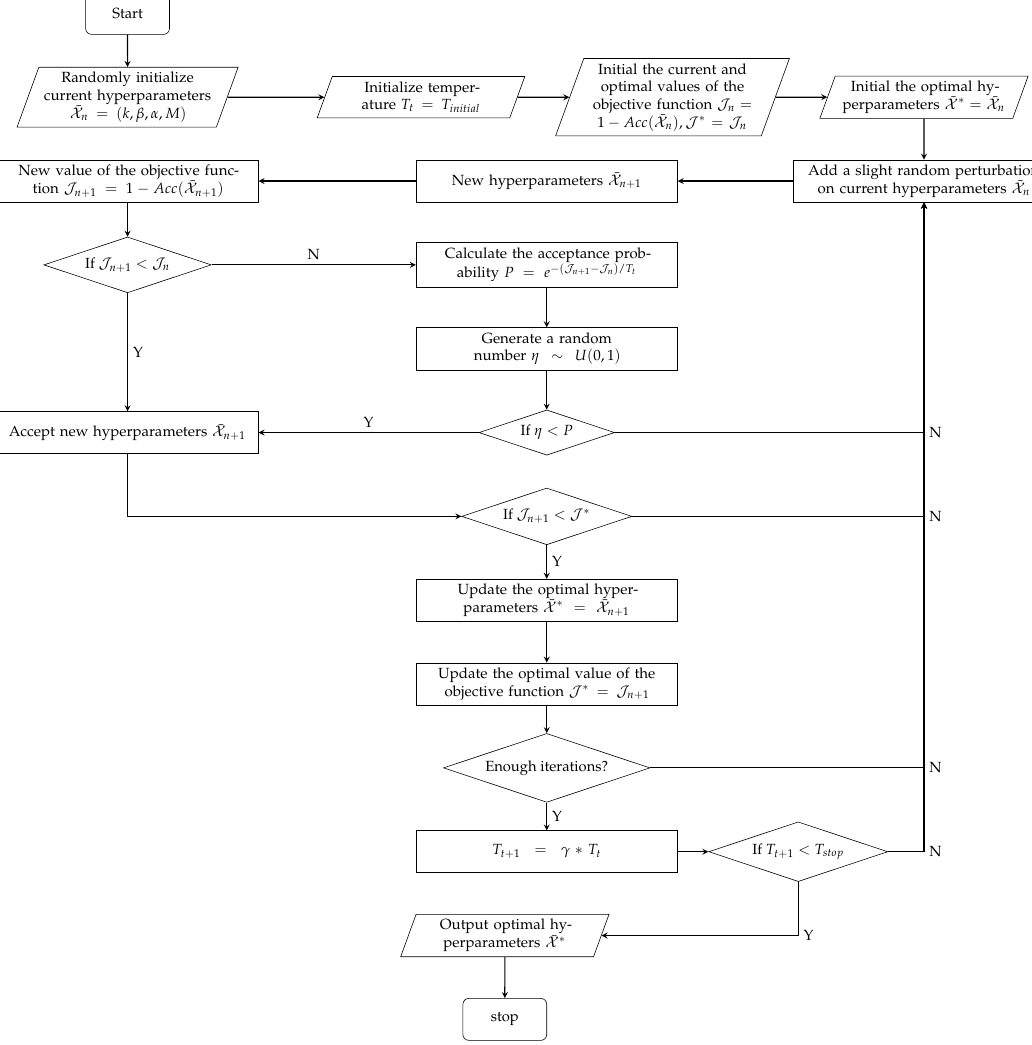
Figure 3. The flow diagram of the Self-Adaptive Hyperparameter Optimization Algorithm. As the temperature decreases, the acceptance probability decreases, helping jump out of the local